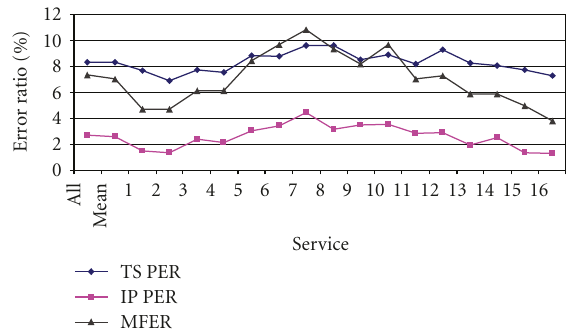
Figure 10: MFER, IP PER, and TS PER for TU6 15Hz channel at C/N = 15dB for 16-QAM 1/2